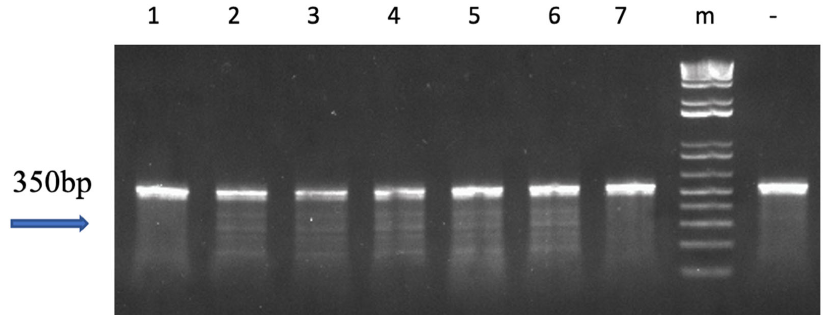
Figure 4. Mutation analysis of follicle-stimulating hormone ( fsh ) gene edited F 1 channel catfish ( Ictalurus punctatus ) using the Surveyor mutation detection test. “-” represents the wild-type DNA as negative control; “m” represents 1 kb DNA molecular weight standards; numbers (2, 3, 4, 5 and 6) show the mutated channel catfish individuals; lanes numbered 1 and 7 show progeny without anticipated mutation. The full gel picture of Figure 4 can be found in Supplementary Figure